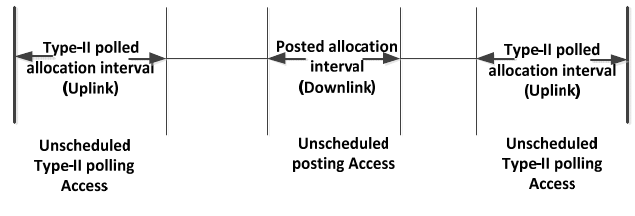
Figure 12. Non-Beacon With Out Superframe Mode [9].